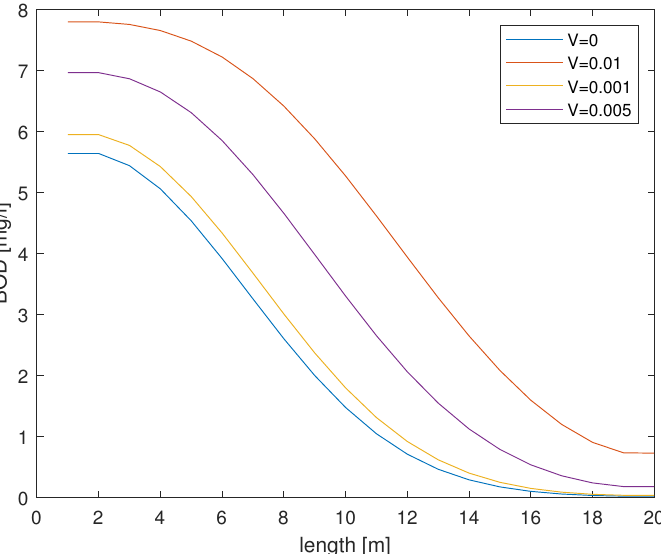
Figure 16. BOD distribution at different velocities in the same time steps. Table 6. BOD values including river self-cleaning process for different water flow rates. BOD [ mg/L ] V [ m/h ] Figure 14 Figure